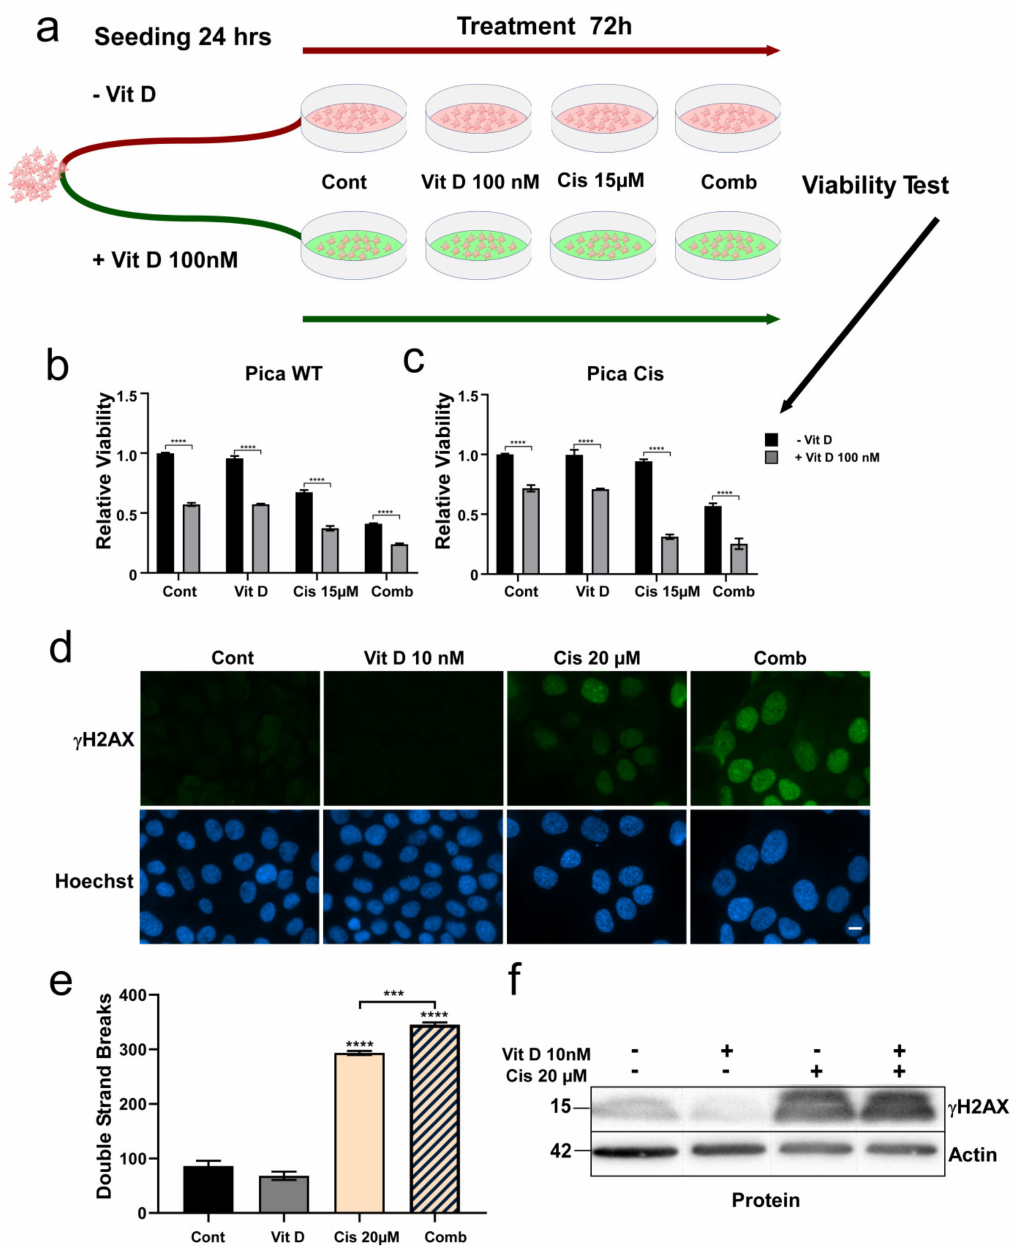
Figure 3. VitD co-treatment allows HNSCC to overcome cisplatin resistance. ( a ) Scheme illustrating the VitD pre-treatment schedule, which mimics physiological high versus low VitD serum levels. Cells were seeded in the presence or absence of 100 nM VitD; after 24 h, cells were treated with 20 µ M cisplatin with and without VitD. ( b , c ) Combinational treatment of VitD/cisplatin synergistically triggered cell death of not only the cisplatin-sensitive ( b ) but also the highly resistant Pica cis cells ( c ). Cells were treated as described in ( a ). The viability of the cells was measured and normalized to untreated controls. ( d ) Fluorescence microscopy was used to visualize DNA damage. Compared to the VitD/cisplatin combination treatment, even cisplatin-treated cells showed a lower number of DNA damage events (quantified as γ H 2 AX damage foci/per cell). Cells were treated for 24 h (10 µ M VitD; 20 µ M cisplatin), and γ H 2 AX foci were detected by specific antibodies. Scale bar, 10 µ m. ( e ) DNA damage events were automatically quantified by high-throughput microscopy and normalized to untreated controls. ***, p < 0.005, **** p < 0.0001 ( f ) Immunoblot analysis confers significantly increased γ H 2 AX levels in VitD/cisplatin co-treated HNSCCUM-02T cells. Actin served as the loading